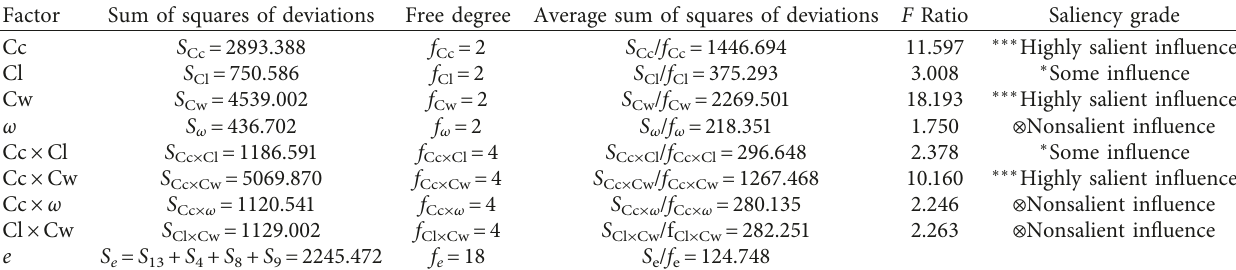
Table 7: Saliency detection of experimental factors and their interactions. Factor Sum of squares of